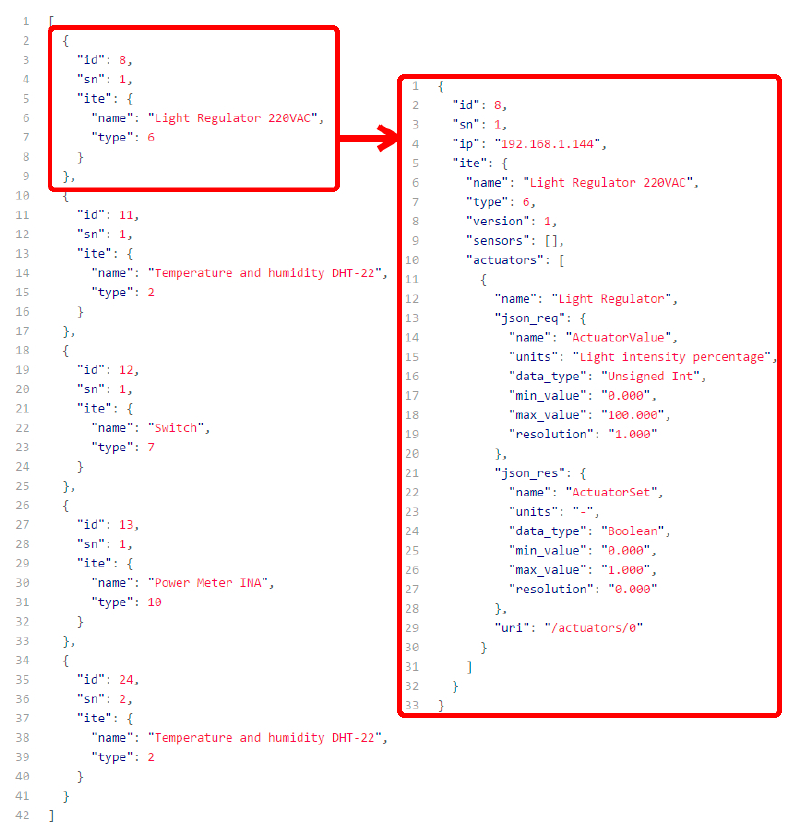
Figure 4. List of the transducers included in HASITE ( left ) with a detailed ITE description of the light regulation ITN ( right